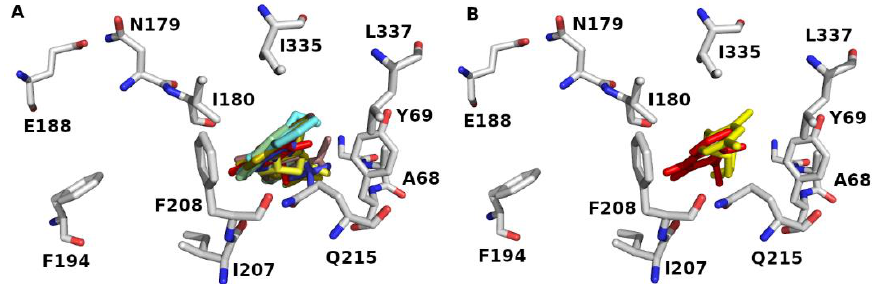
Figure 4. MAO-A (PDB ID: 2Z5X) binding domain ( A ) orientation of Glide docked poses of J series and ( B ) overlaying of the Glide docked pose of J14 (red color) and original geometry of (clorgyline ( S1 ) (yellow color). Some of key binding residues are shown, and H atoms are hidden for clarification. Picture visualized by PYMOL [32] .